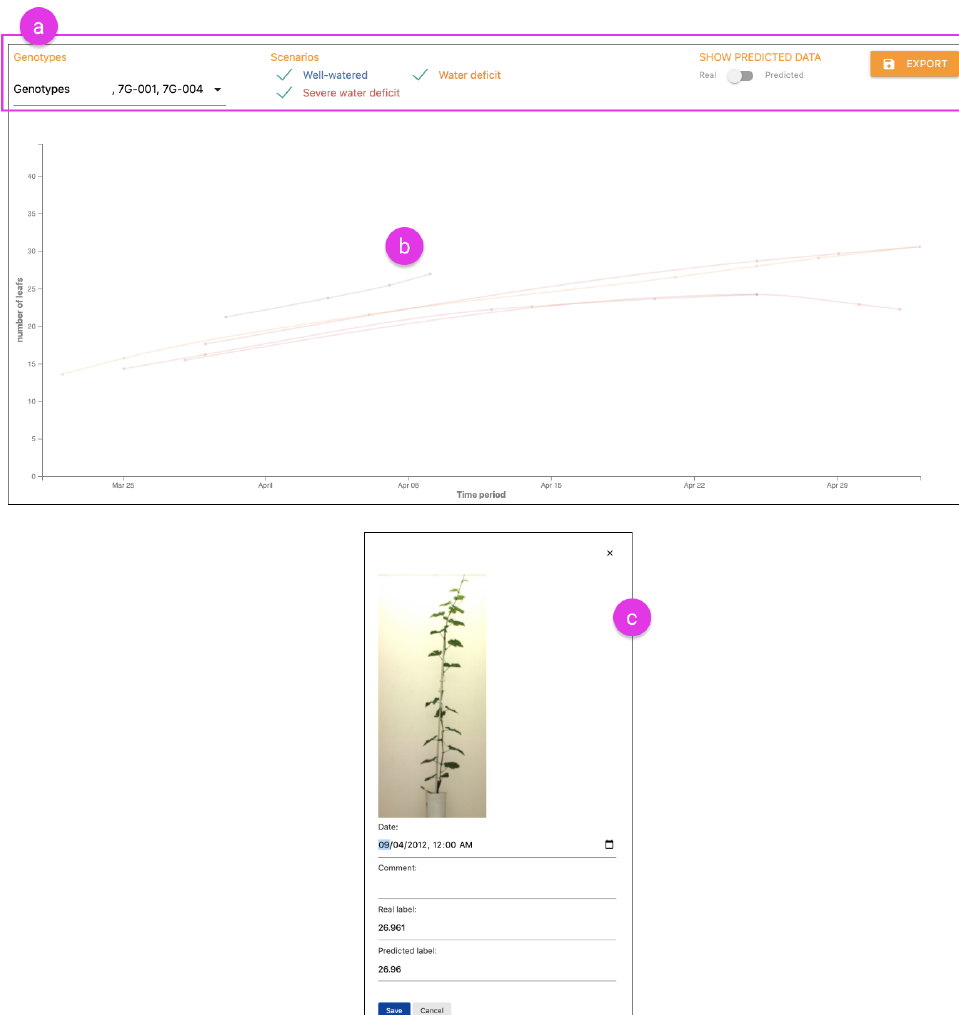
Figure 3. Interface for the analysis of plant growth: ( a ) toolbar; ( b ) the line graph representing the plants; ( c ) a popup window showing an image of the plant captured on the given